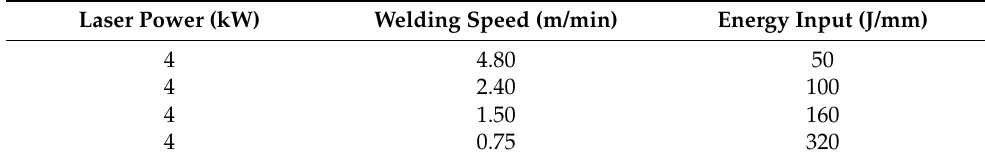
Table 3. Laser welding